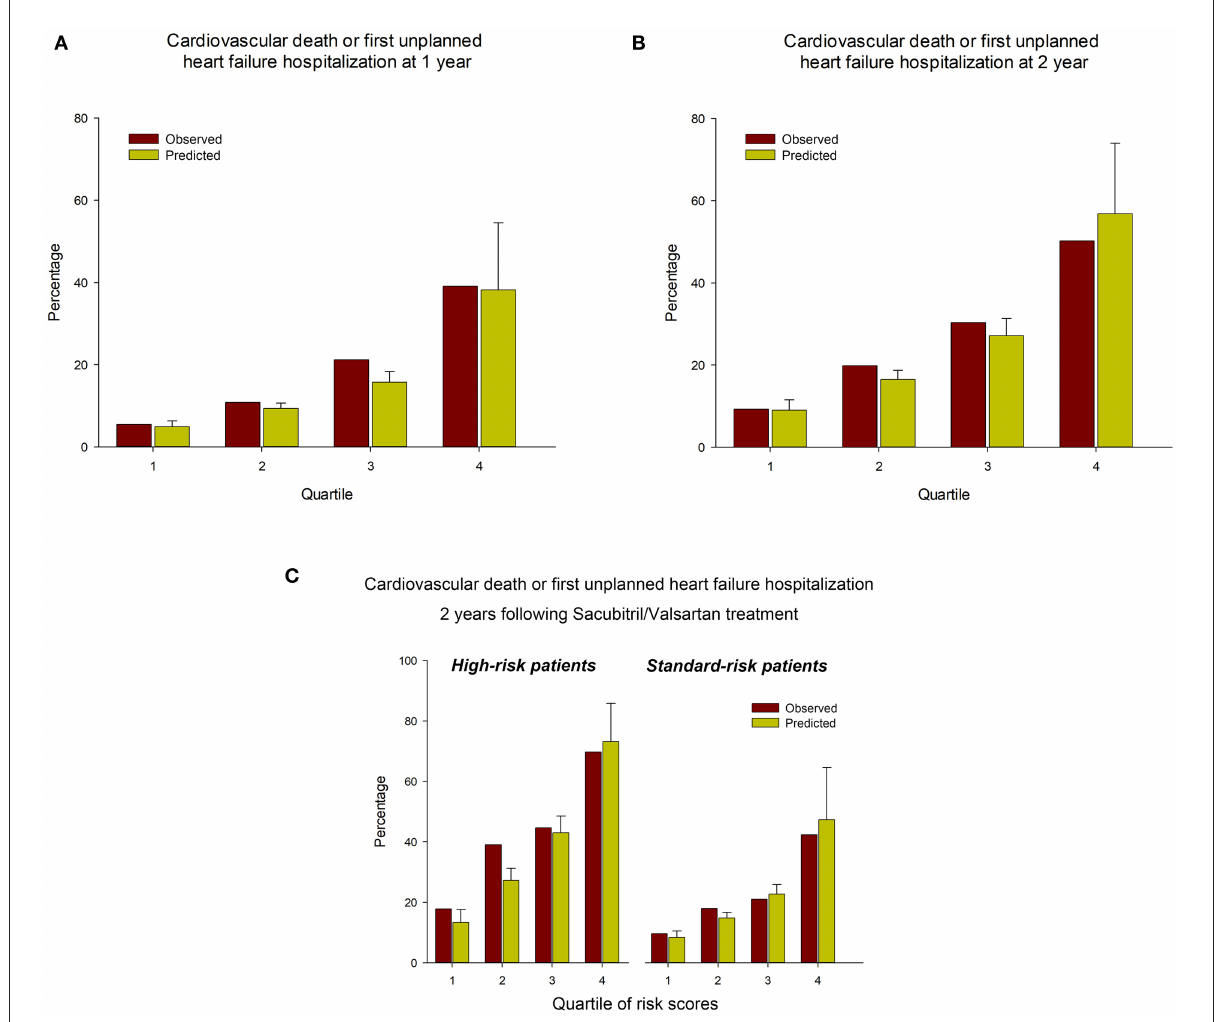
FIGURE2 Comparisons between the predicted and observed probabilities of cardiovascular death or first unplanned HFH across patient risk quartiles at (A) 1 year and (B) 2 years. (C) Predicted vs. observed probabilities of cardiovascular death or first unplanned HFH, stratified by high/standard-risk and quartile of PREDICT-HF risk